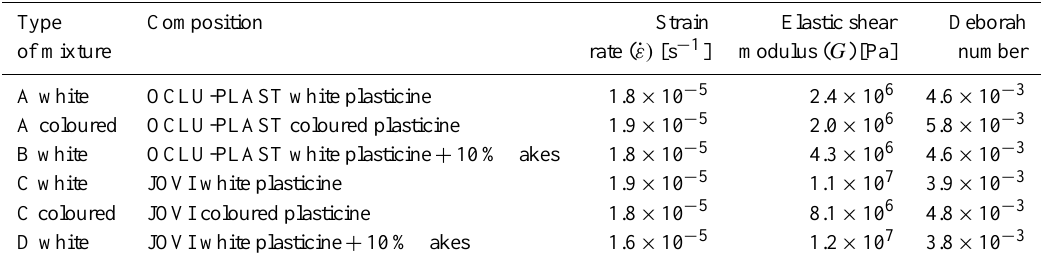
Table 2. Summary of material properties calculated with relaxation tests for the different mixtures used as rock analogues. Only tests deformed at similar strain rates than multilayer experiments are displayed. The values of elastic shear modulus ( G) and Deborah number ( De ) were calculated assuming a Maxwell